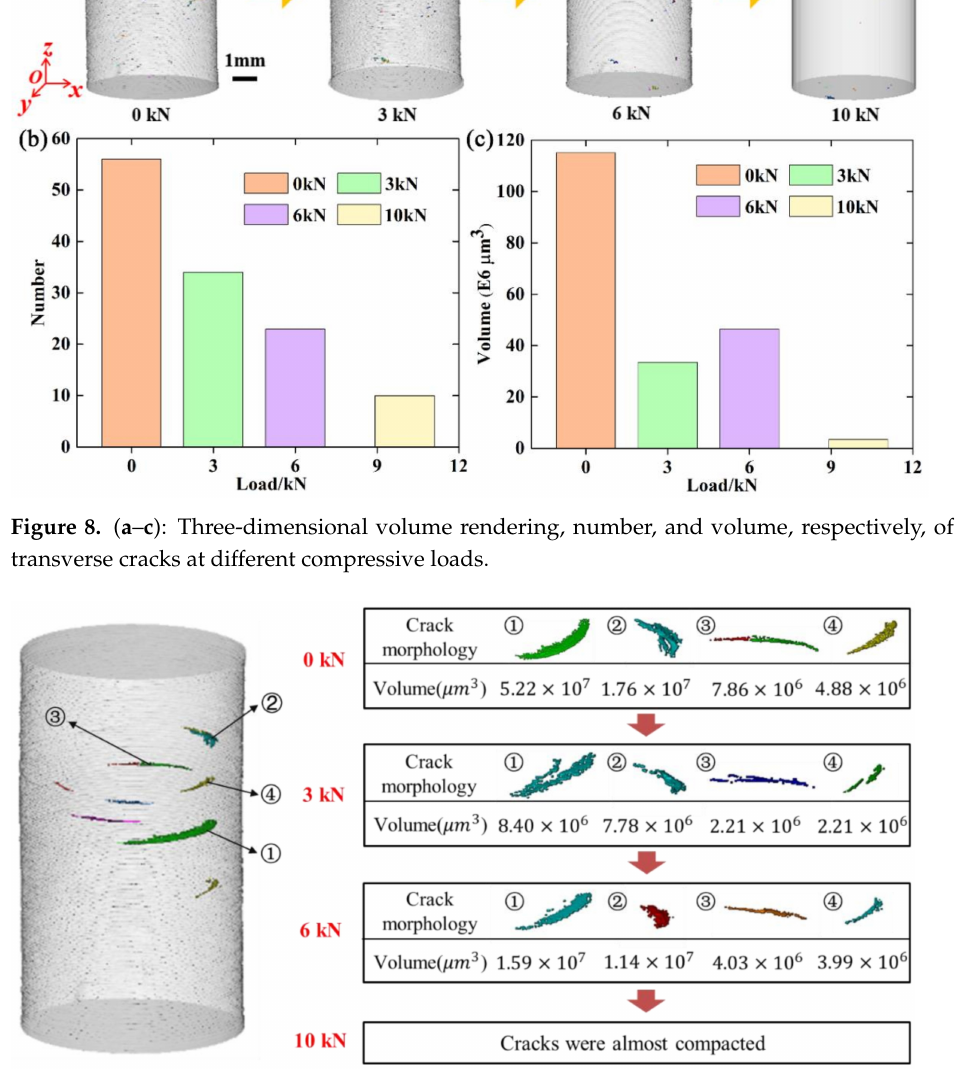
Figure 9. ( a ) Schematic of representative transverse cracks; ( b ) volumes of representative trans- verse